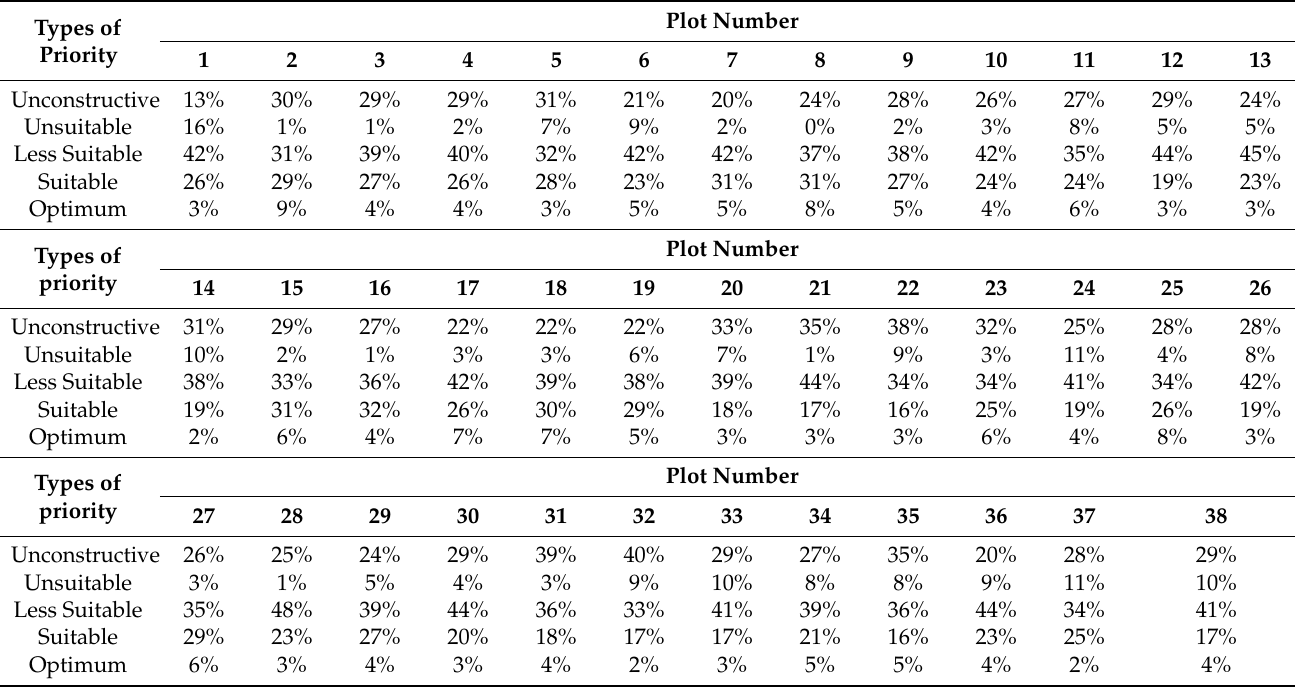
Table 7. The area proportion of each priority of multi-functional rainwater storage space in each